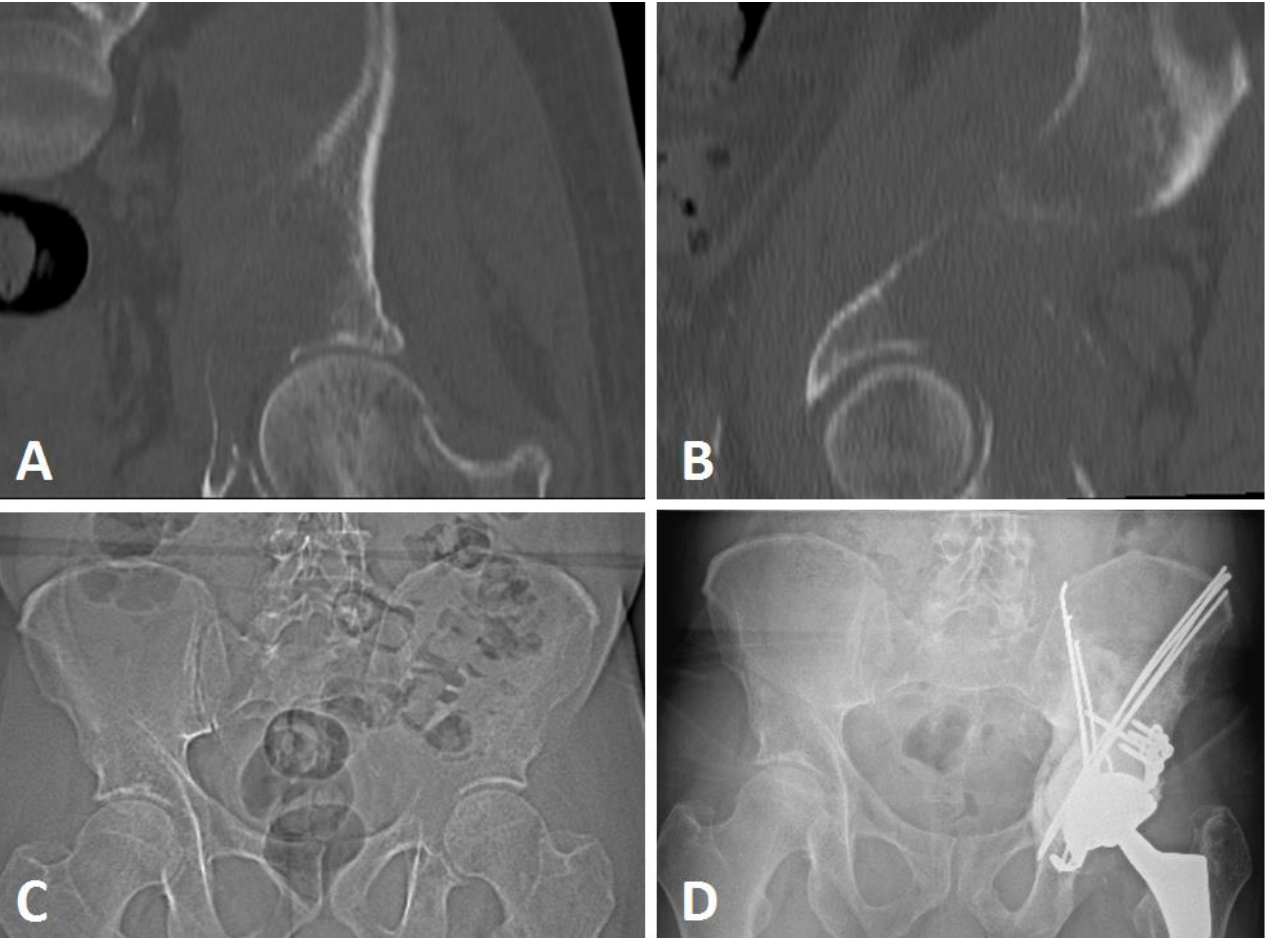
Figure 7. Imaging views of a renal clear cell carcinoma metastatic iliac lesion Harrington class III. Frontal view ( A ) of the periacetabular lesion, sagittal view ( B ), X-ray AP view of the pelvis before surgery ( C ), and postoperative X-ray ( D ) at 22-month follow-up.